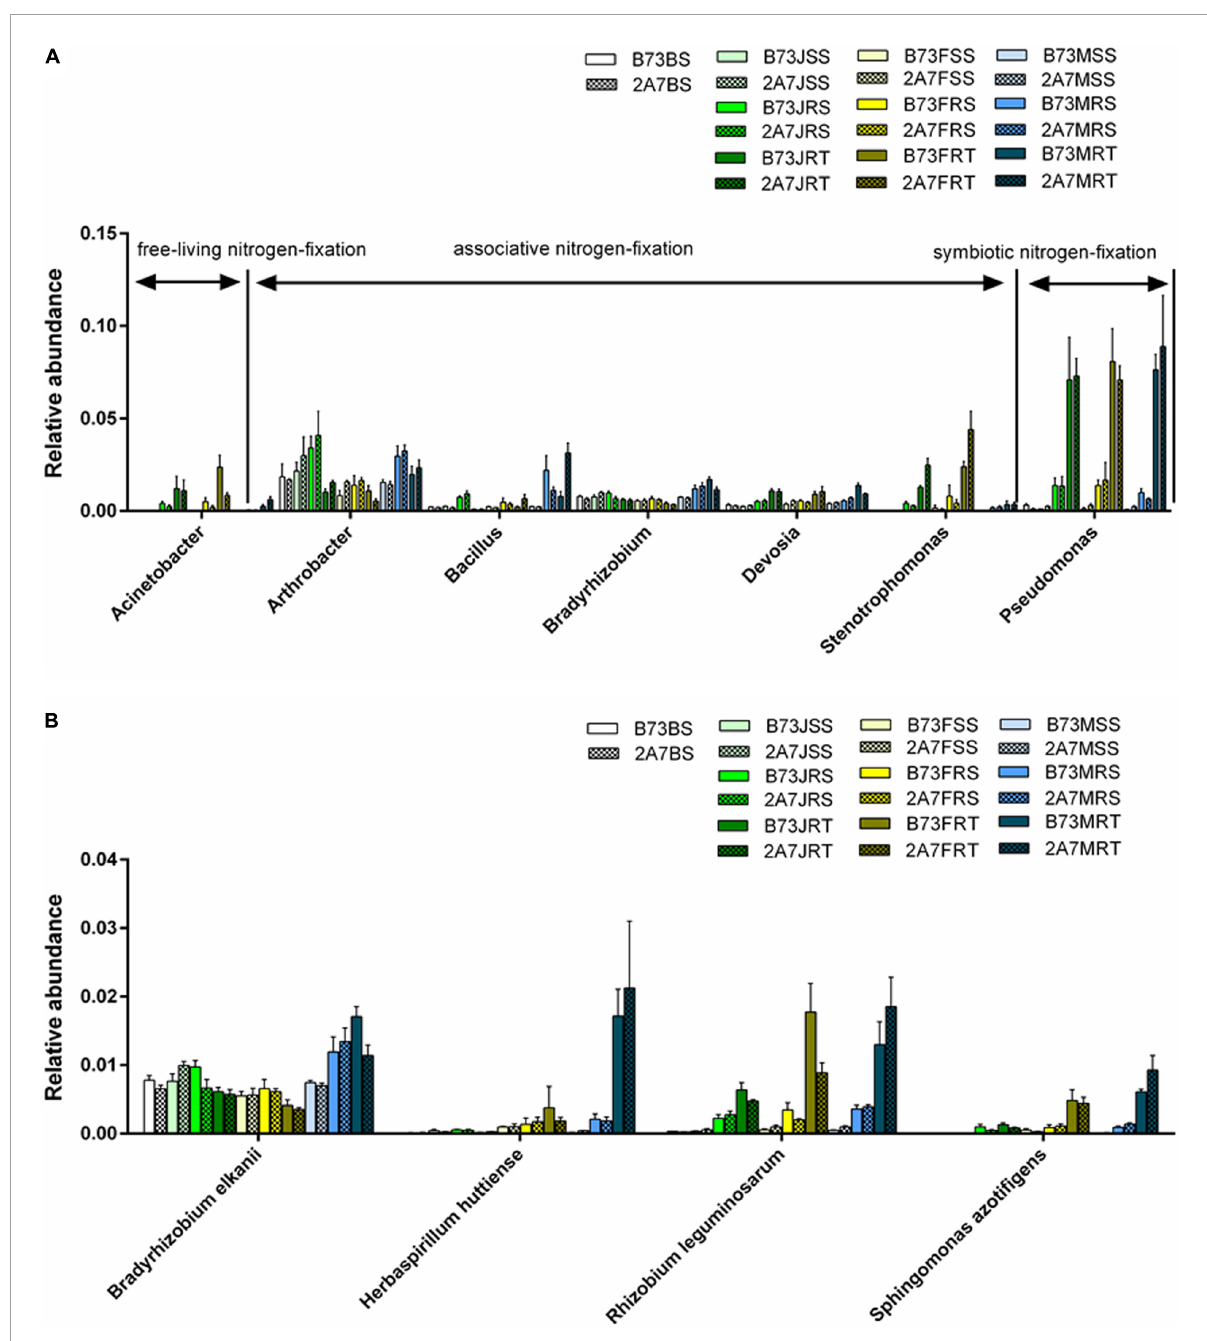
FIGURE3 The composition and abundance of bacteria related to nitrogen fixation in maize root-associated bacterial community. (A) The abundance of seven nitrogen-fixation bacteria at genus level. (B) The abundance of four nitrogen-fixation bacteria at species level. Values are mean ± SD ( n = 3), treatment’s details were as in Figure 2